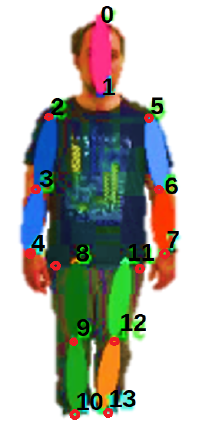
Figure 1. Location of 14 points in the human body that are recorded during exercise: 0. Head; 1. Chin; 2. Right shoulder joint; 3. Right arm elbow joint; 4. Wrist joint of right hand; 5. Left shoulder joint; 6. Left arm elbow joint; 7. Left wrist joint; 8. Right side hip joint; 9. Knee joint of the right leg; 10. Ankle joint of right leg; 11. Left side hip joint; 12. Left leg knee joint; and 13. Left ankle